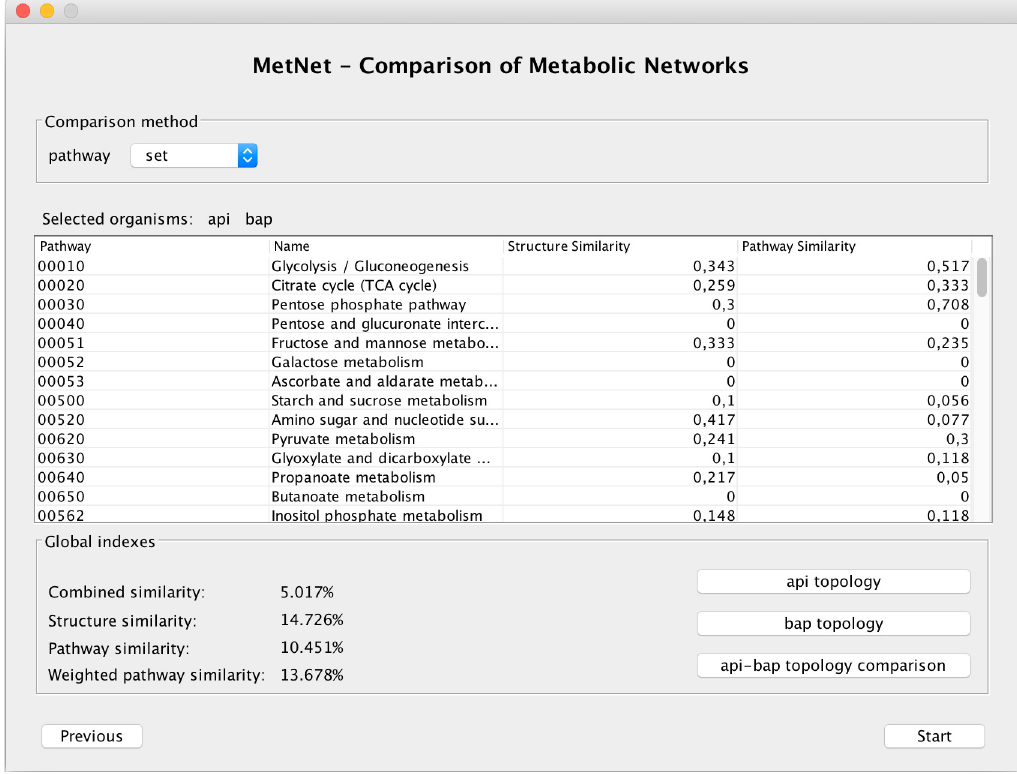
Fig 4. Comparison results for api and bap